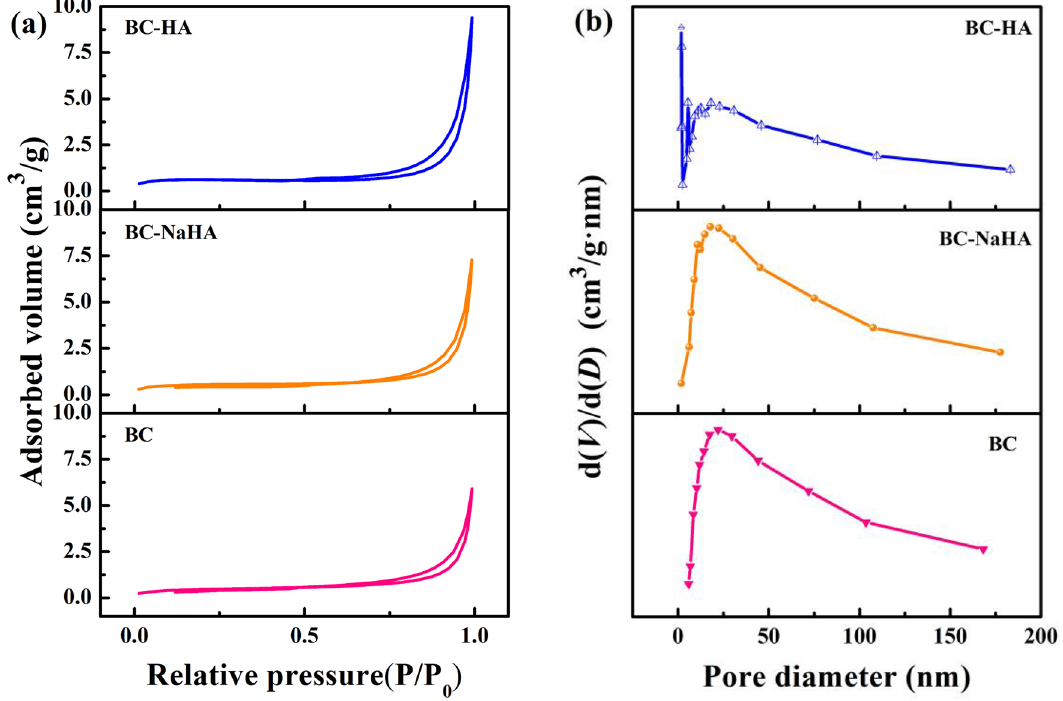
Figure 8. ( a ) N 2 adsorption–desorption isotherms of BC, BC-NaHA and BC-HA; ( b ) pore size distributions.